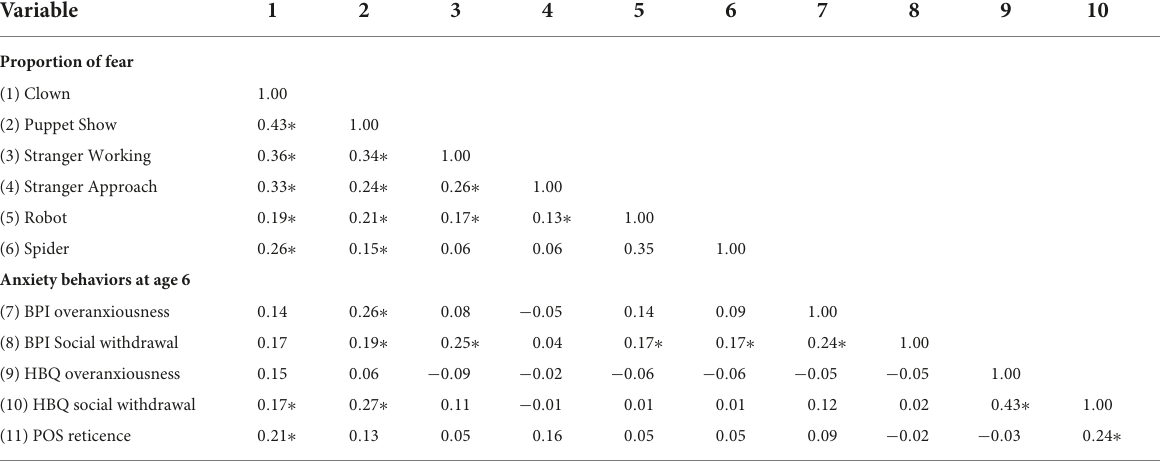
TABLE 2 Bivariate correlations of key variables of